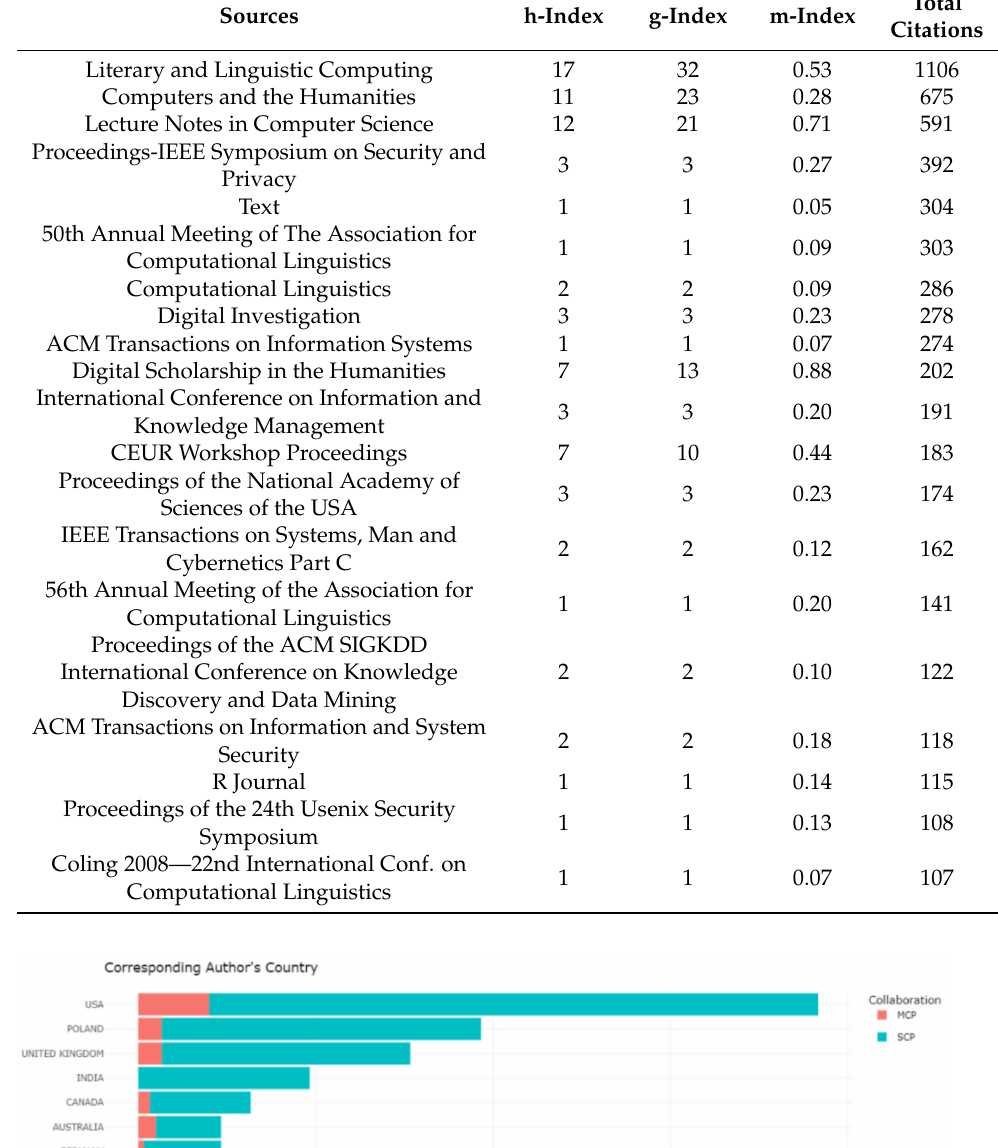
Table 3. Top 20 of the highest-influence sources based on total citations.